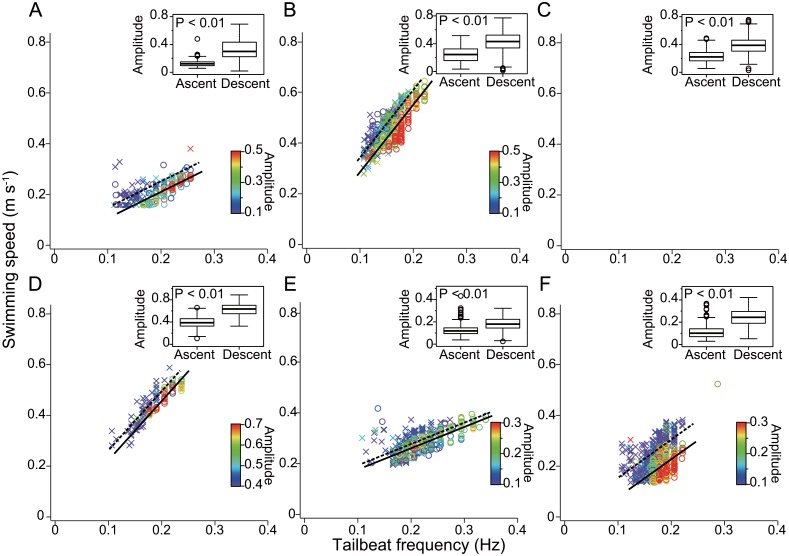
Relationships between swimming speed and tailbeat frequency during vertical migrations.A 202-cm male prickly shark (A), a 461-cm female sixgill shark (B), a 450-cm female sixgill shark (C; no swimming speed data), a 416-cm female sixgill shark (D), a 333-cm male sixgill shark (E; with a counter-weight) and a 440-cm male sixgill shark (F; with a counter-weight). Plots indicate ascent (×) and descent (◯), and colours indicate amplitude of acceleration signal. Lines are estimated by generalized linear models with lowest Akaike information criteria. The models indicate swimming speed increased with increasing tailbeat frequency, and swimming speeds at given tailbeat frequencies were slower during descent (solid lines) than during ascent (broken lines) in all individuals. Boxplots in the graphs show amplitude of acceleration signal during ascent and descent. The bottom and top of the box are the first and third quartiles, and the band inside the box is the median. The end of the whiskers indicate the lowest datum still within 1.5 of the interquartile range of the lower quartile, and the highest datum still within 1.5 of the interquartile range of the upper quartile. The circles indicate outliers. All individuals had significantly higher amplitude during descent than ascent.